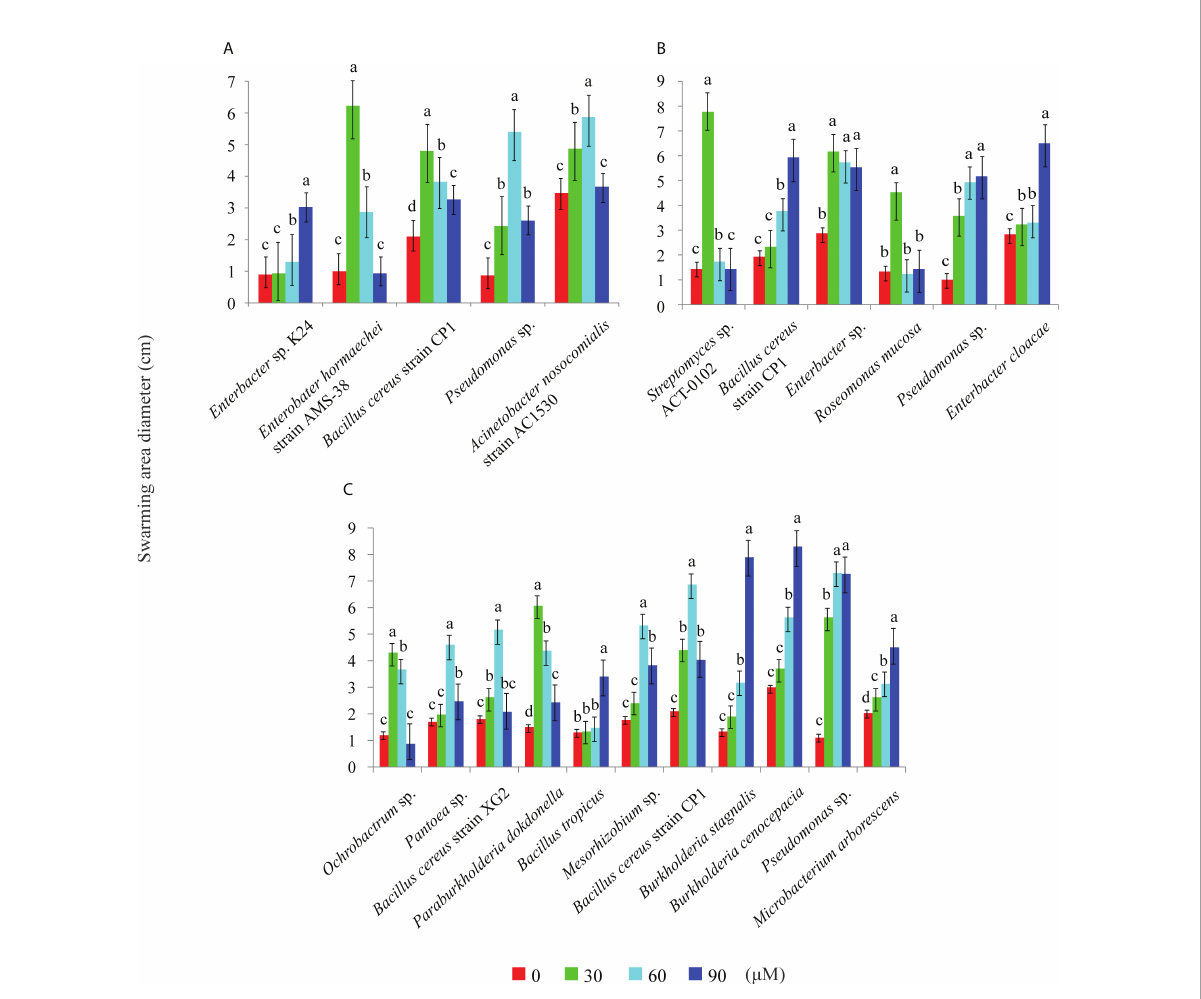
FIGURE 2 Effect of chemoattractants on the swarming motility of different bacteria. Swarming diameters were measured for chemoattractants at concentrations of 0, 30, 60, and 90 m M. (A) : 2, 4-di-tert-butylphenol; (B) : methyl stearate; (C) : arginine. Different letters above the columns indicate signi fi cant difference ( P <